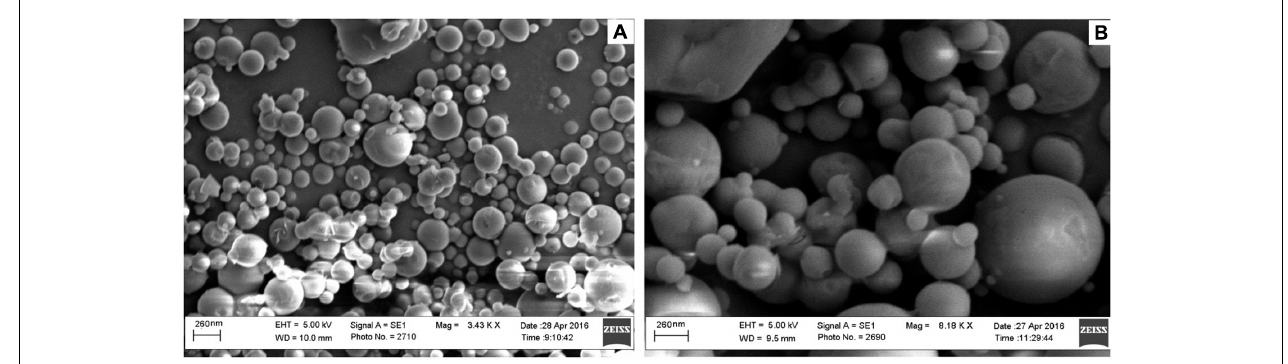
FIGURE 6 | Scanning electron microscopic (SEM) images of (A) plain and (B) coated PLGA NPs.